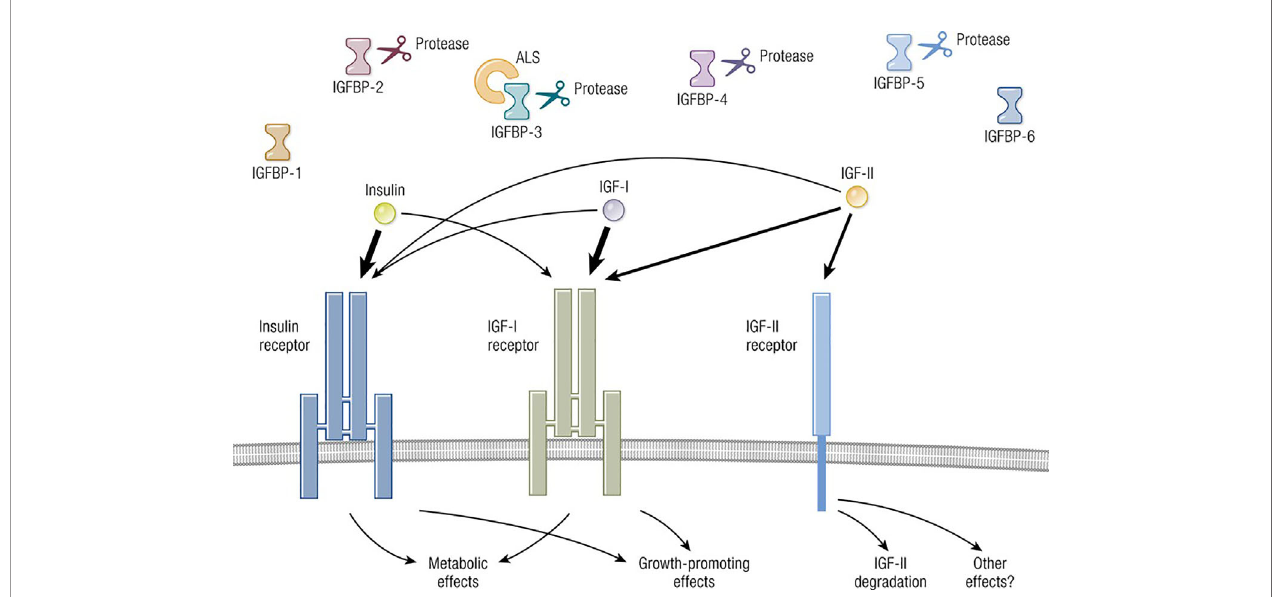
FIGURE 1 | Overview of the IGF-I pathway, including its multiple ligands, modulatory binding proteins and receptors. Ligands including IGF-I, IGF-II, and insulin share important structural and functional relationships including the promiscuous utilization of multiple receptors, such as IGF-IR, IGF-IIR, and IR. The pathway also contains IGF-binding proteins (IGFBPs) which can function either independently or may require ligation. IGF-IR plays a central role in mediating growth regulation. In contrast, the insulin receptor is the primary regulator of metabolism and carbohydrate handling. IGF-IIR (mannose-6-phosphate receptor) in fl uences IGF-II degradation and participates in the biology of the Golgi apparatus. Biological impact of both IGF-I and IGF-II action is modulated by six thus-far identi fi ed IGFBPs. Adapted from Lowe WL. Insulin-like growth factors. Science & Medicine 1996; 3;